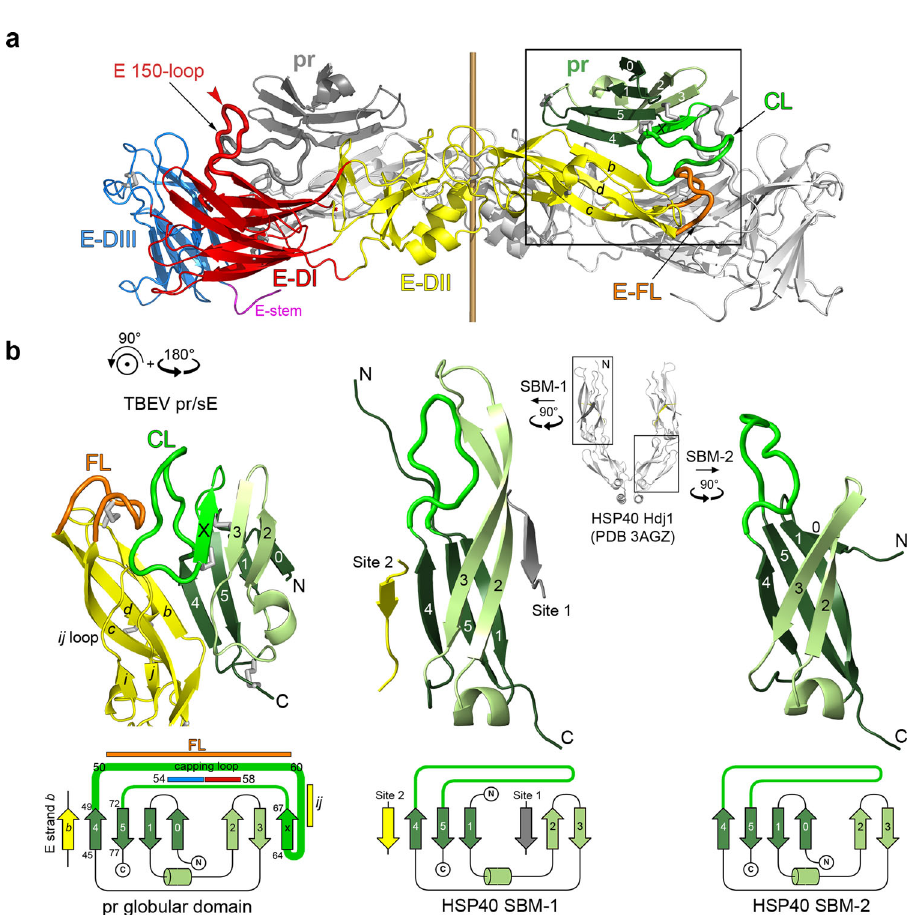
Fig. 3 pr is a homolog of the substrate binding domains of HSP40/DnaJ chaperonins. a The (pr/sE) 2 dimer shown in side view as ribbons, with one protomer in colors as in Fig. 2a and the other in grey. The various domains are labeled, and a central bar indicates the crystallographic 2-fold axis of the complex. A red arrowhead marks the location of glycosylated Asn154 in the 150-loop. b The framed region in ( a ) is shown in the left panel, rotated as indicated, to match the orientations of the SBM-1 and − 2 domains of the human HSP40 Hdj1 chaperonin shown in the middle and right panels, respectively. An inset in between the middle and right panels shows the X-ray structure from which the SBMs were extracted, and corresponds to the Hdj1 (PDB 3AGZ) 66 HSP40 chaperonin dimer with two HSP70-bound peptides. The rotations applied to the SBM-1 (middle panel) and SBM-2 (right panel) are indicated. The pr capping loop (CL; thicker line, bright green) corresponds to an extension of the β 4 β 5 loop in the SBMs, which is postulated to be involved in interactions with substrate. In pr, the extension leads to an additional strand, labeled β X . The two peptides bound to SBM-1 are indicated in grey (site 1) and yellow (site 2), with the color emphasizing the correspondence between the pr/sE association and site 2 binding through main-chain β interactions. Different shades of green are also used to highlight equivalent regions of pr and the SBMs, displayed in the same shades. The topological organization of the displayed beta sandwiches is shown at the bottom of each panel. Colored bars on the topology diagram of pr indicate the regions of interaction with E, color-coded as de fi ned in the legend to Fig. 2a. Residue numbers along the pr topology diagram are a guide to indicate residues forming β -strands and segments of the capping loop interacting with the indicated regions of